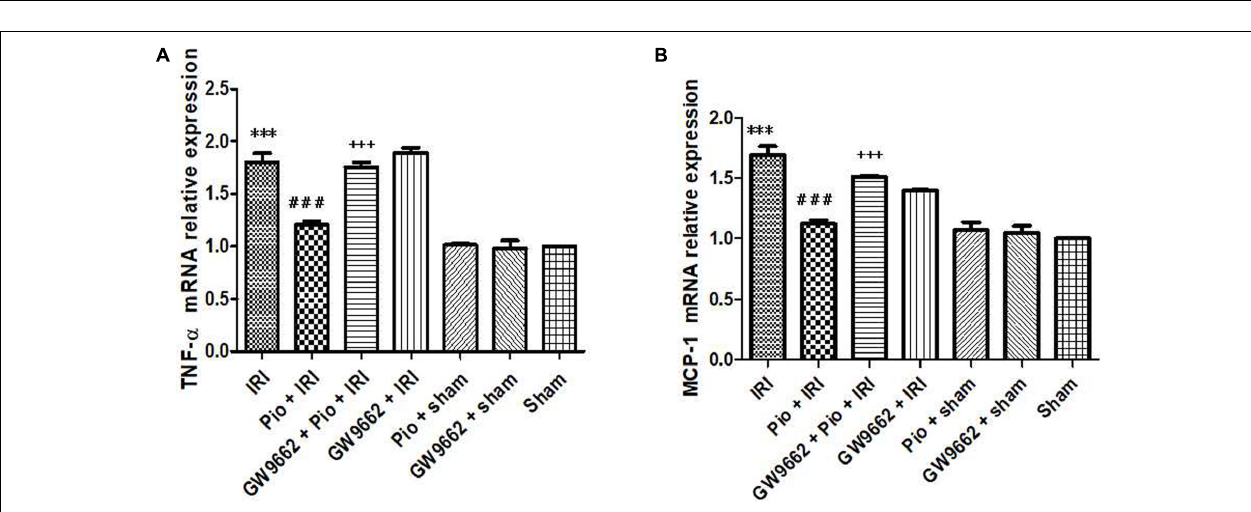
FIGURE 6 | Pioglitazone decreases the mRNA expression of inflammation markers, including TNF- α and MCP-1, in the renal tissues at 24 h after renal IRI. (A,B) TNF- α and MCP-1 expression levels in the renal tissue of each group, respectively. Values are expressed as mean ± SE ( n = 3). Compared to the sham group, ∗∗∗ represents p < 0.001; compared to the IRI group, ### represents p < 0.001; compared to the Pio + IRI group, +++ represents p <